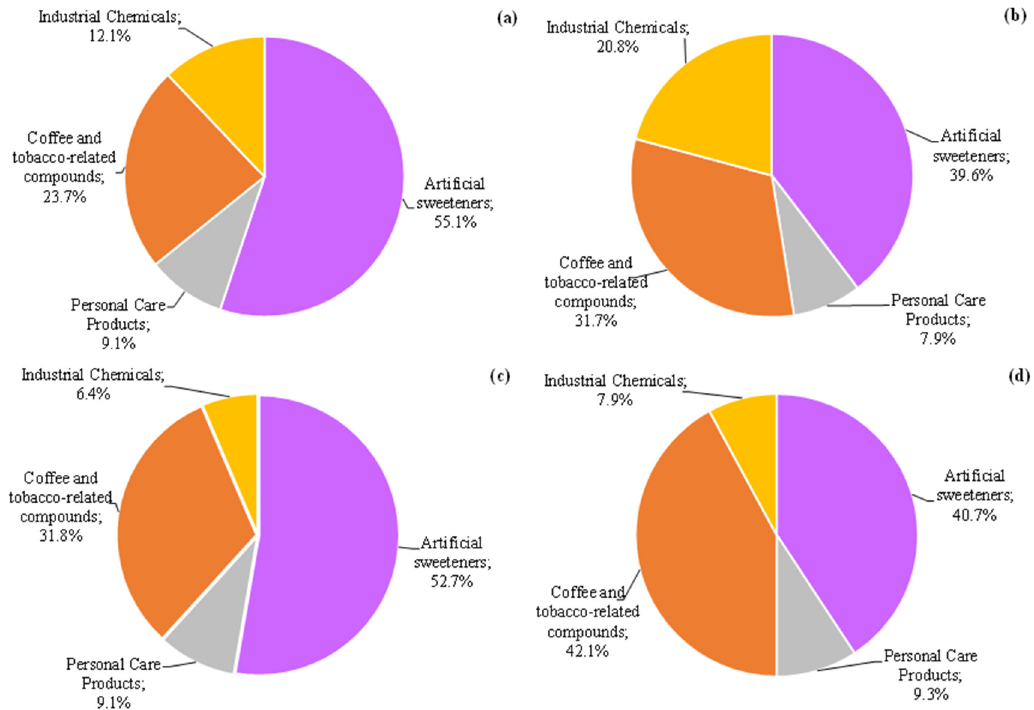
Figure 2. Contribution of each class of compounds to the total concentration of emerging contaminants detected in ( a ) Point A/Period 1, ( b ) Point B/Period 1, ( c ) Point A/Period 2, and ( d ) Point B/Period 2.